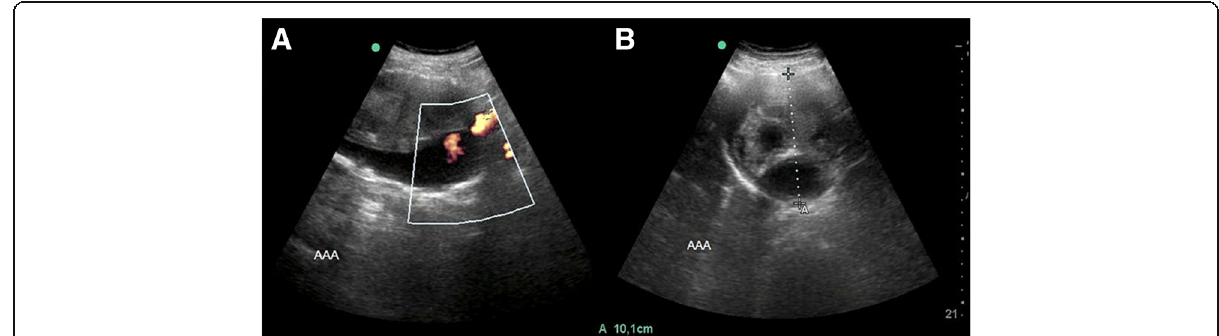
Fig. 3 a, b . Ultrasonographic study in a 65 year old male patient with an Abdominal Aortic Aneurysm (AAA) (A), with a maximum diameter of 10.1 cm (cm) determined by this imaging study. Permission to reproduce granted by Permanyer Hinojosa CA, Bermudez-Serrato K, Anaya-Ayala JE, et al. Proactive measurements in the search of aortic aneurysms have an impact in the prevalence. Cir Cir. Article in